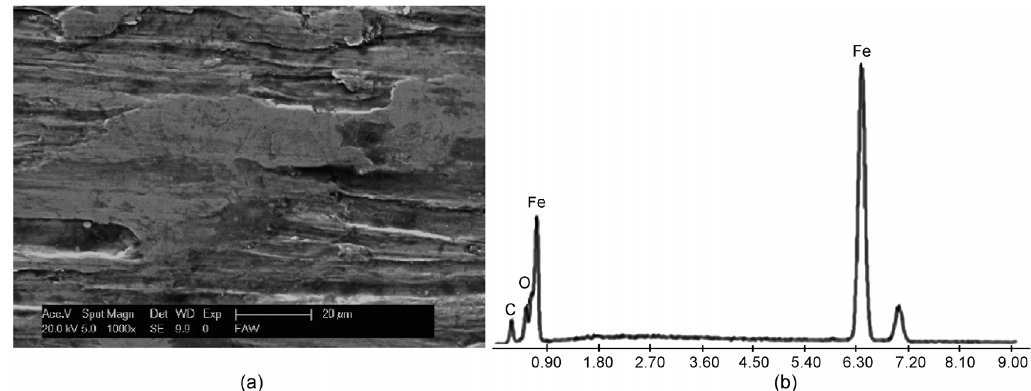
Fig. 9 Wear trace of the cylinder liner under dry sliding conditions with CNTs. (a) SEM image, and (b) EDS